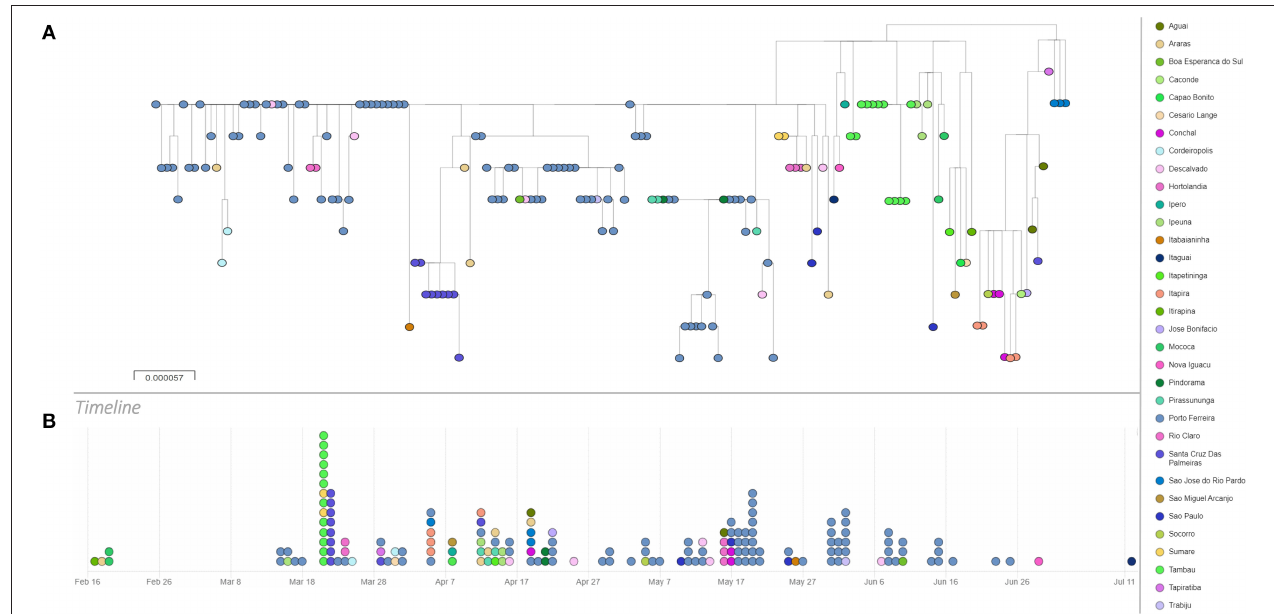
FIGURE 2 | Phylogeny and timeline of P.4 lineage. (A) . Maximum Likelihood Phylogenetic tree based on a dataset of 166 complete genome P.4 lineage sequences of SARS-CoV-2. Tree was reconstructed based on GTR + G + I model. (B) . Timeline of the detection of lineage P.4. This analysis is available at https://microreact.org/